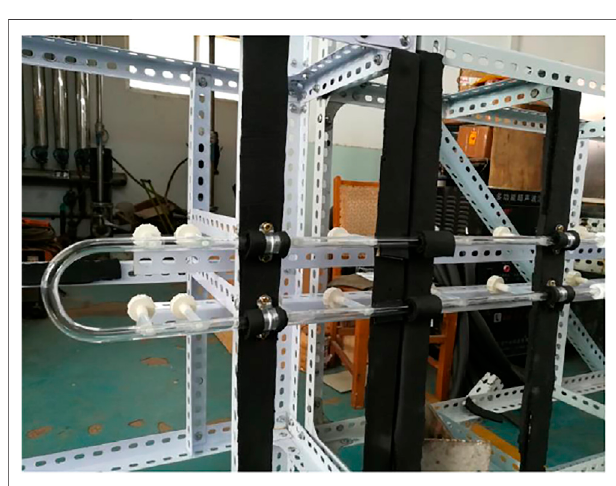
found to be longer in the upward fl ow for vertical U-bends.